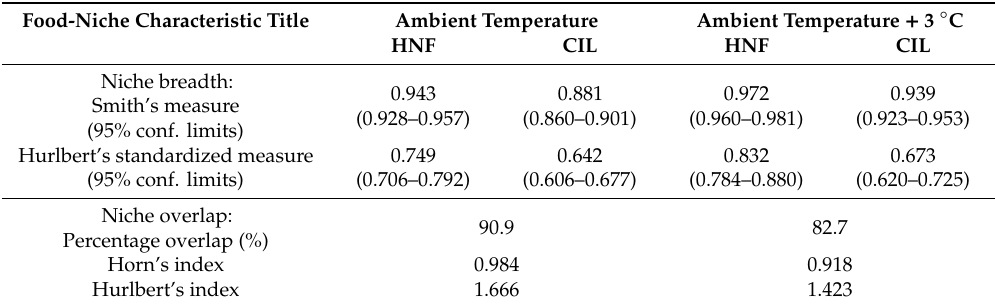
Table 2. Food-niche breadth of heterotrophic nanoflagellate (HNF) and ciliate (CIL) predators and food-niche overlap between them.